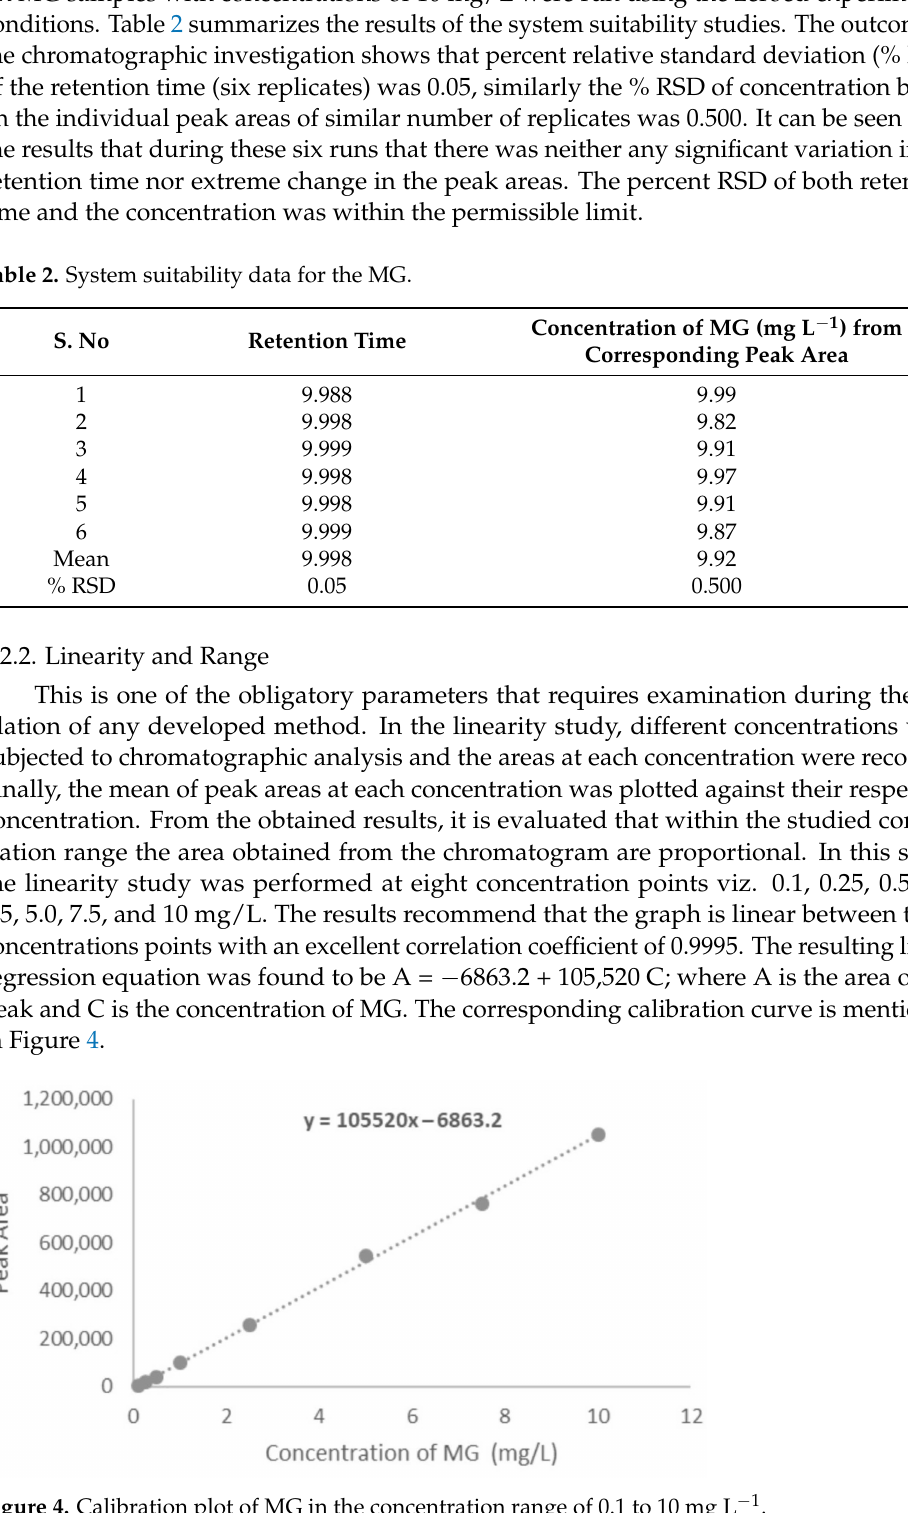
Figure 4. Calibration plot of MG in the concentration range of 0.1 to 10 mg L − 1